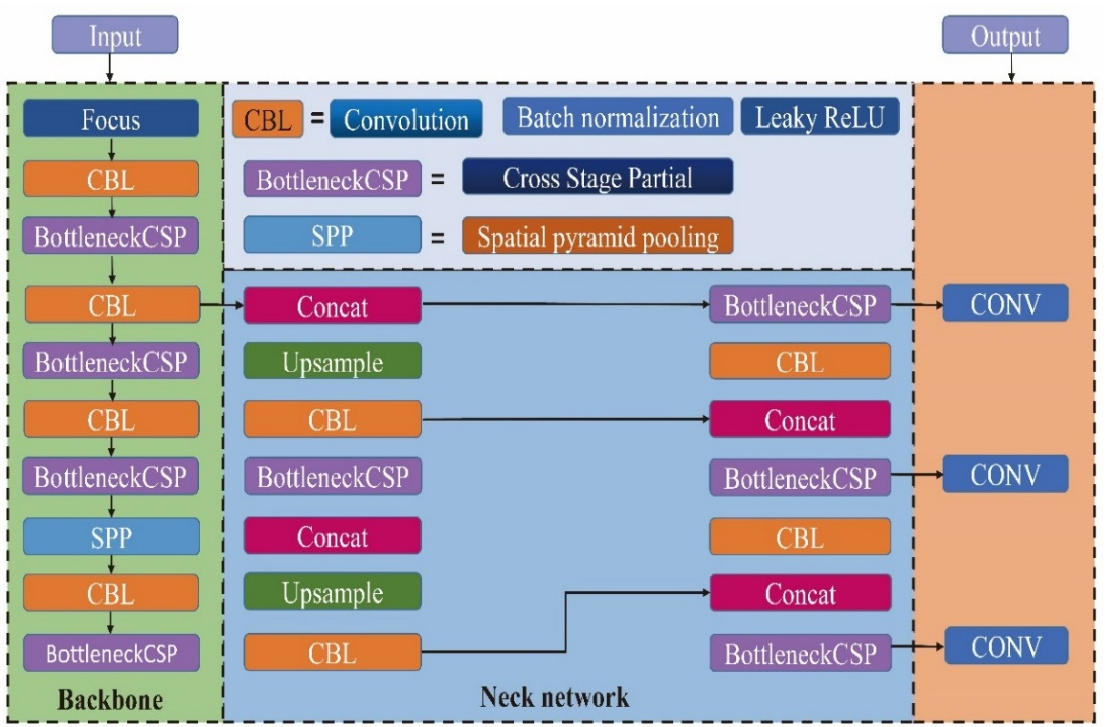
Figure 3. YOLOv5l model structure.